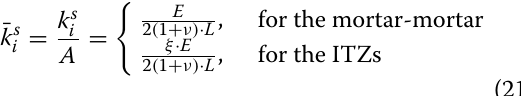
Table 3 MPB variables accessed dynamically during